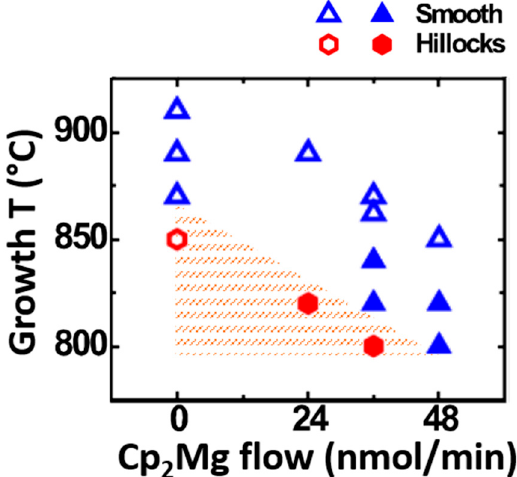
Figure 5. Chart of the presence of hillocks with varying temperature and Mg precursor flow. “Hillocks” are defined as samples showing hillocks under 50× magnification (40 × 30 µm). The empty symbols correspond to 200 nm thick layers, with 2 nm InGaN/2 nm GaN SLs, whereas filled symbols represent 100 nm thick layers with 2 nm InGaN/0.7 nm GaN SLs. The shaded region shows the growth parameter range in which hillocks will appear, and the hypotenuse marks the samples which are hillock-free under 50× magnification, but show some hillocks under 20× magnification.